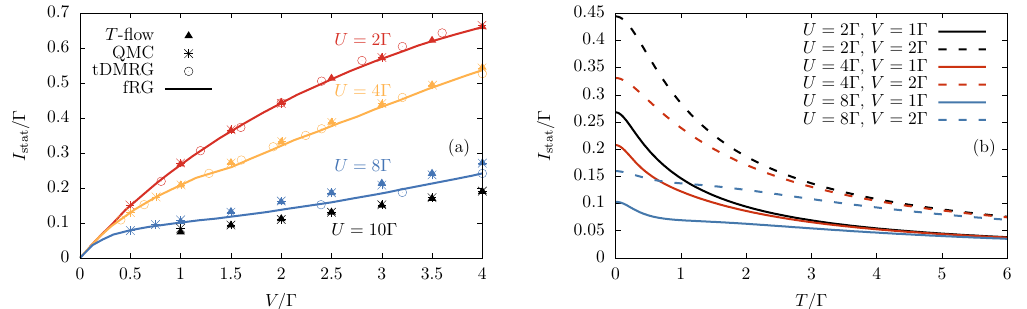
Figure 1: Stationary current at the symmetry point ε = − U / 2. (a) Comparison of the stationary current I at T = 0 as function of bias V between the T -flow method, stat fRG, tDMRG and QMC. (b) Stationary current as function of